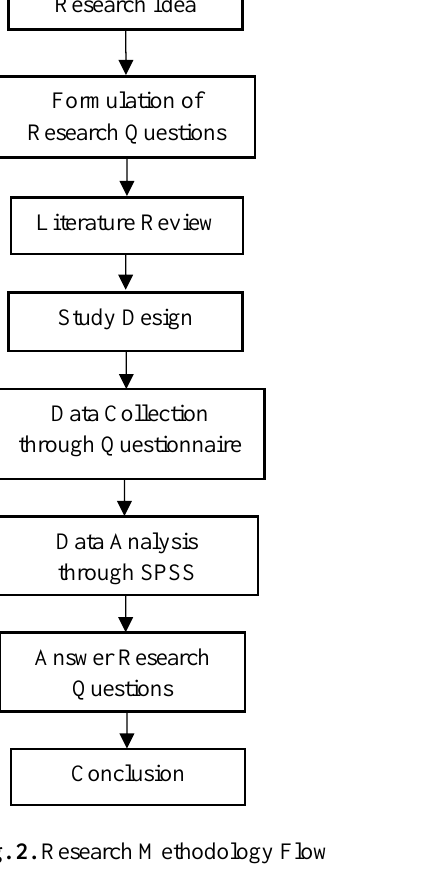
Fig. 2. Research Methodology